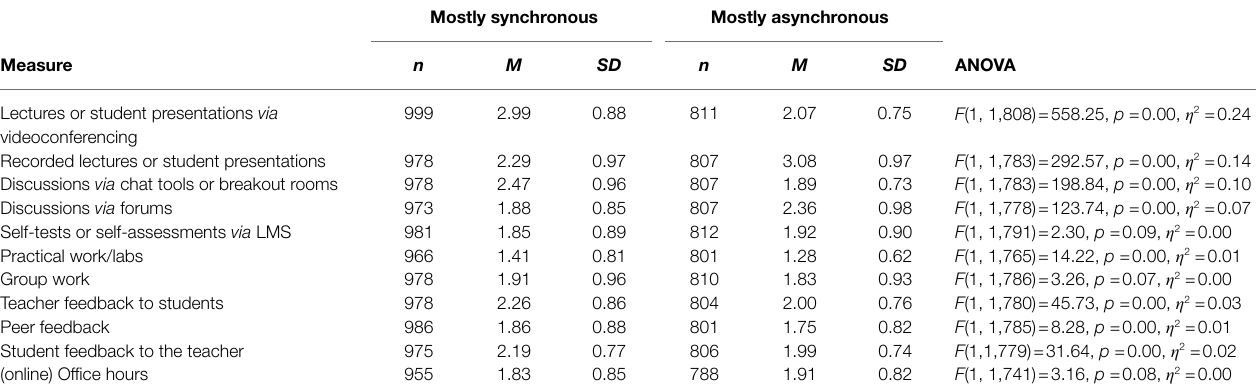
TABLE 3 | Descriptive results for groups and group comparisons of student perceptions of teaching and learning methods. Mostly synchronous Mostly asynchronous Measure n SD